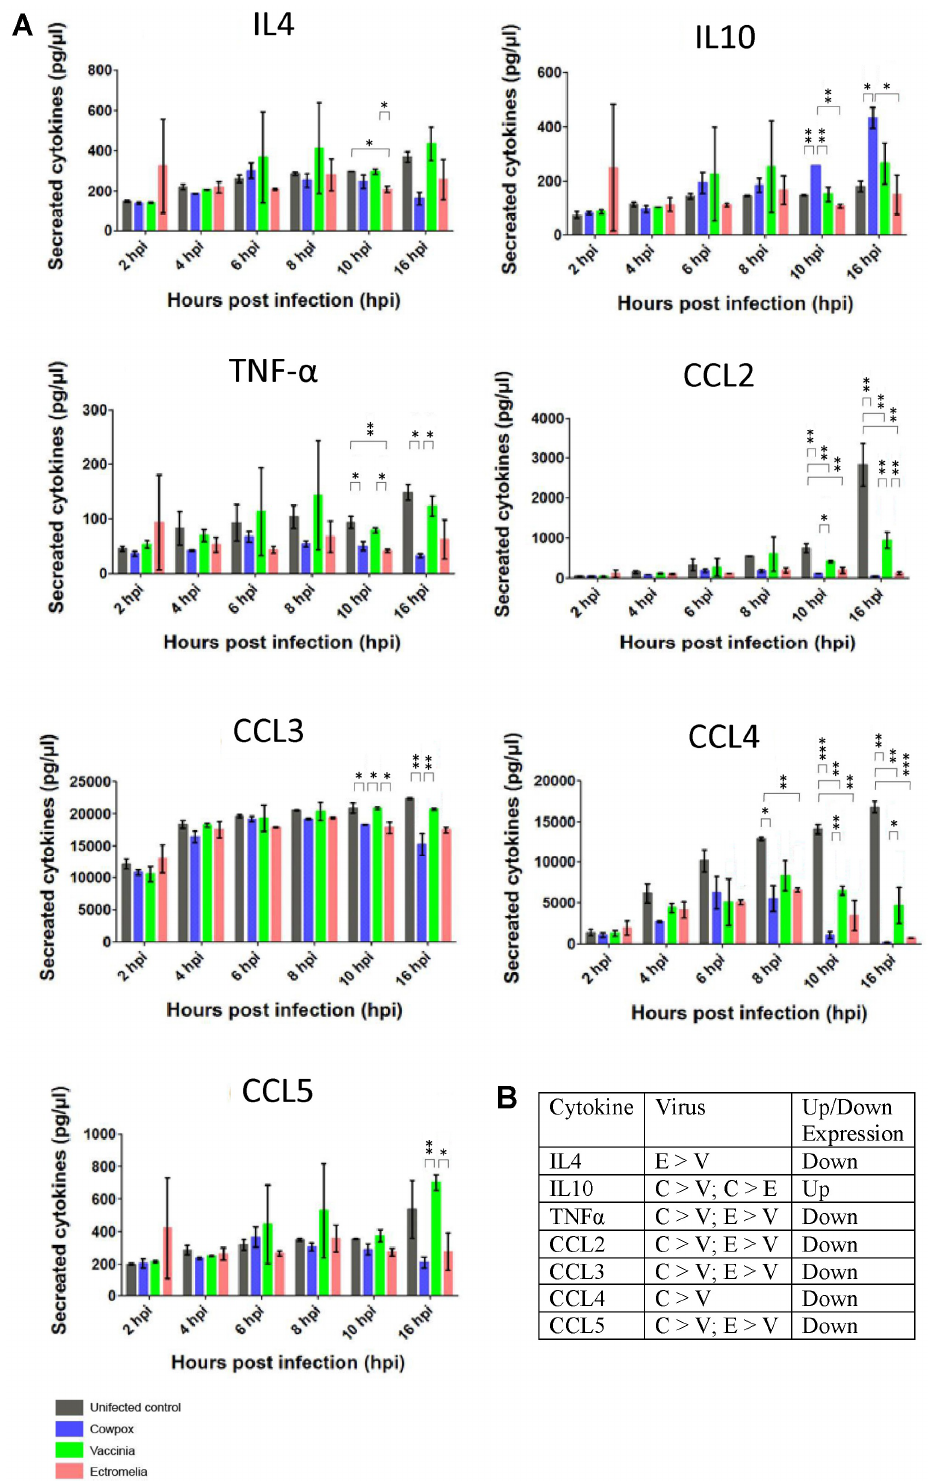
Figure 5. Detection of cytokines in the supernatant of RAW cells infected with cowpox virus, ectromelia virus and vaccinia virus. ( A ) From 2, 4, 6, 8, 10 and 16 h post-infection (hpi), the secreted cytokines were measured with the Bio-Plex Mouse Cytokine 23-Plex Panel (#M60009RDPD, Bio-Rad, Inc., Hercules, CA, USA). Data was analyzed using the Bio-Plex Manager software (Bio-Rad, Inc., Hercules, CA, USA) and pairwise analysis was performed with * representing p value < 0.05; ** < 0.01; and *** < 0.001. The amount of cytokines are indicated in pg/ µ L on Y-axis and time of infection as hpi is indicated on X-axis. ( B ) Table showing significant differences among the 3 viruses. C = cowpox virus, E = ectromelia virus and V = vaccinia virus. Up/Down indicates up-regulation or down-regulation of cytokine levels. Error bars are analysed from the average of 3 readings per